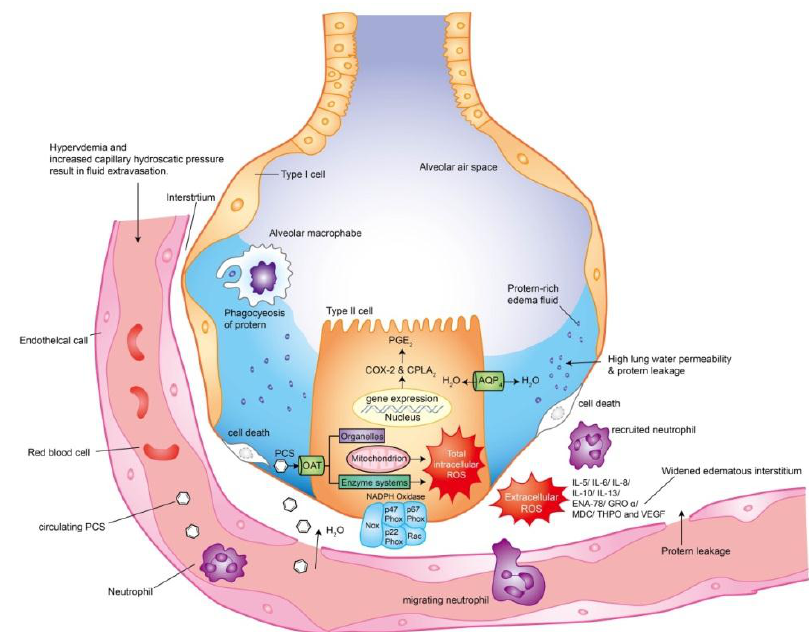
Figure 5. Intricate pathomechanisms of uremic lung injury in chronic kidney disease: Intra-alveolar and extra- alveolar cell responses.